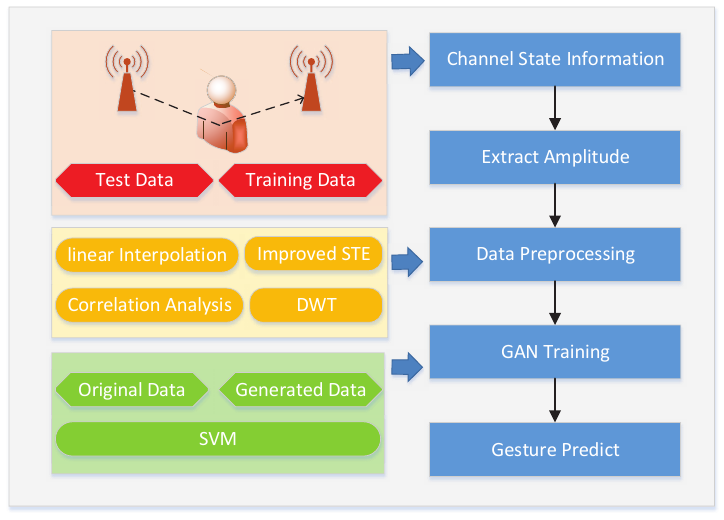
Figure 1. The flow of our gesture